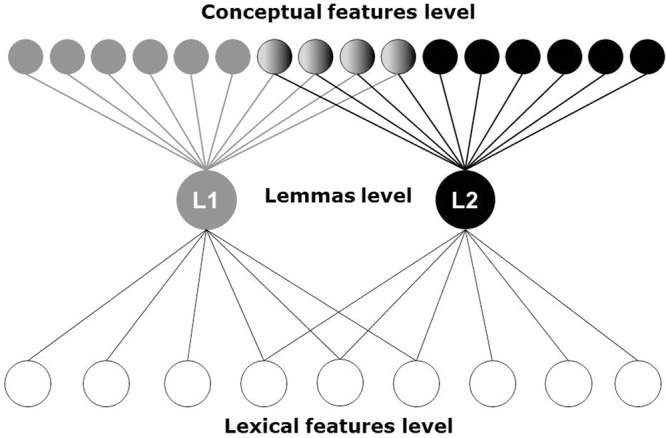
The distributed lexical/conceptual feature model of bilingual memory consists of three levels of representation: a conceptual feature, a lexical feature, and a lexical-semantic (lemma). L1, first language; L2, second language. Adopted from Kroll and de Groot (1997).